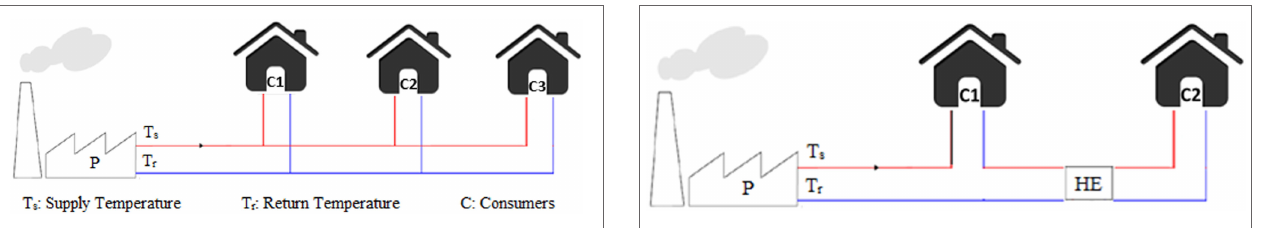
FIGURE 3 | Schematic plan of the DHS based on the distance from heat source .